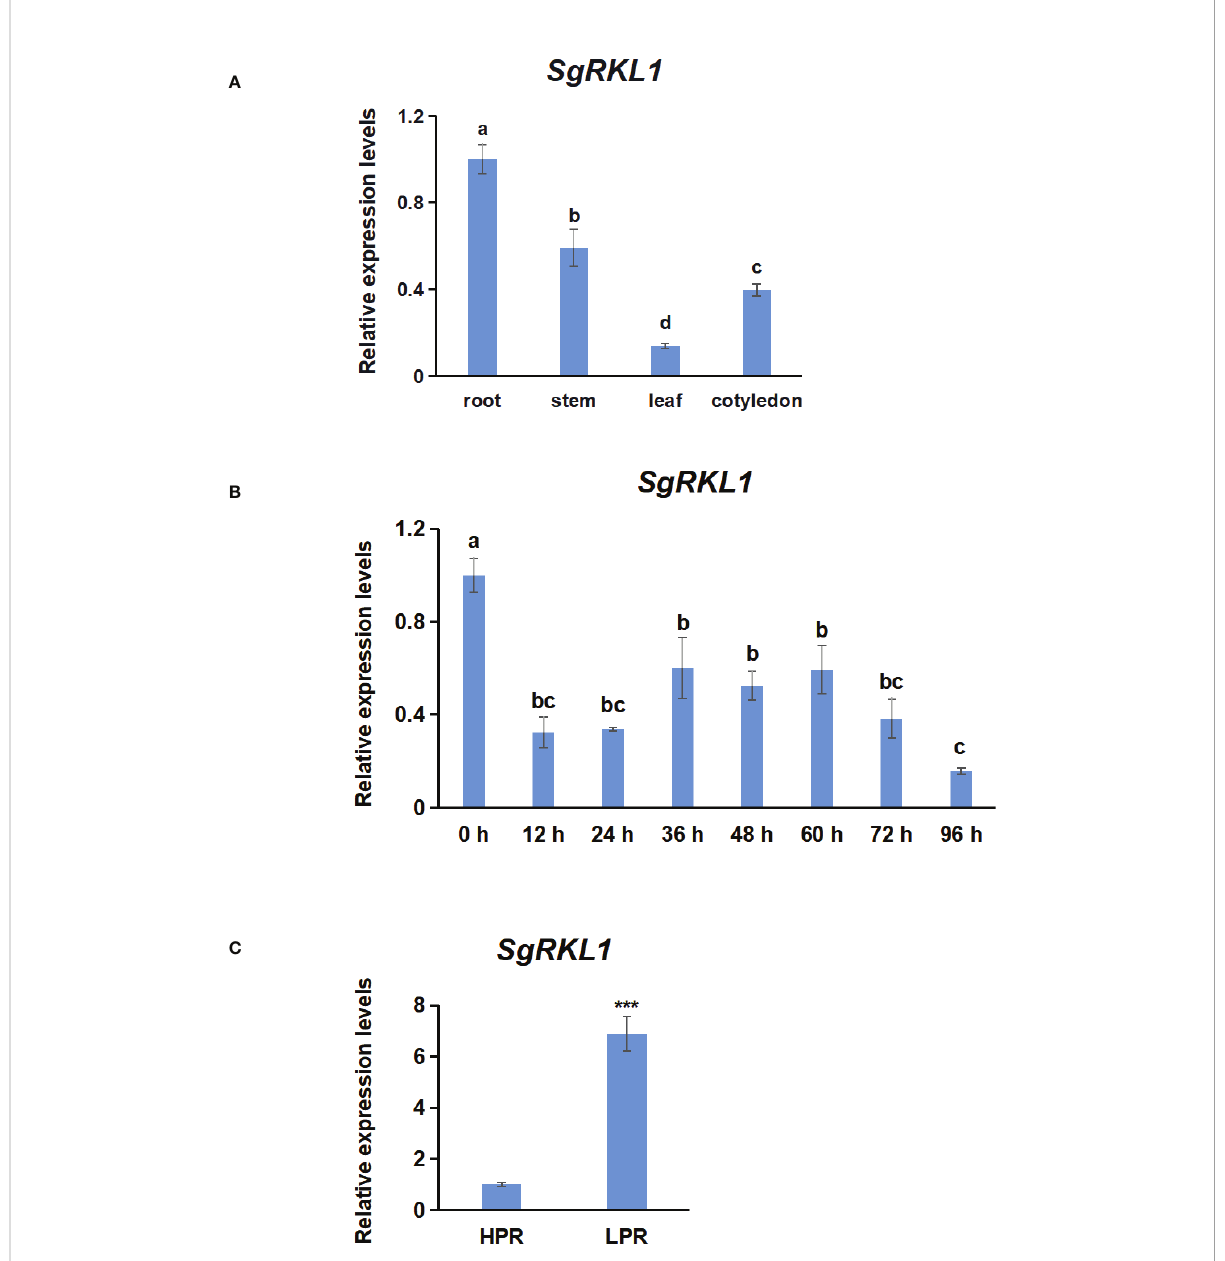
FIGURE 9 Analysis of expression pattern of SgRKL1 by qPCR. (A) Expression pattern analysis of SgRKL1 gene in different tissues of stylo under normal growth condition. (B) Expression pattern analysis of SgRKL1 gene in leaves of stylo post inoculation with C gloeosporioides . Leaves samples were collected at 0 h,12 h,24 h, 36 h, 48 h, 60 h, 72 h and 96 h post inoculation of C gloeosporioides . (C) Expression pattern analysis of SgRKL1 gene in roots of stylo under low phosphorus treatment. HPR represents the treatments with a phosphorus concentration of 300 m mol/L, and LPR represents the treatments with a phosphorus concentration of 0 m mol/L. Data are means ± SE pooled from three biological replicates, n = 3. Different letters in (A) and (B) indicate signi fi cant differences using Dancan ’ s test ( P < 0.05). Asterisks in (C) indicate signi fi cant differences using the Student ’ s t-test (*** P <